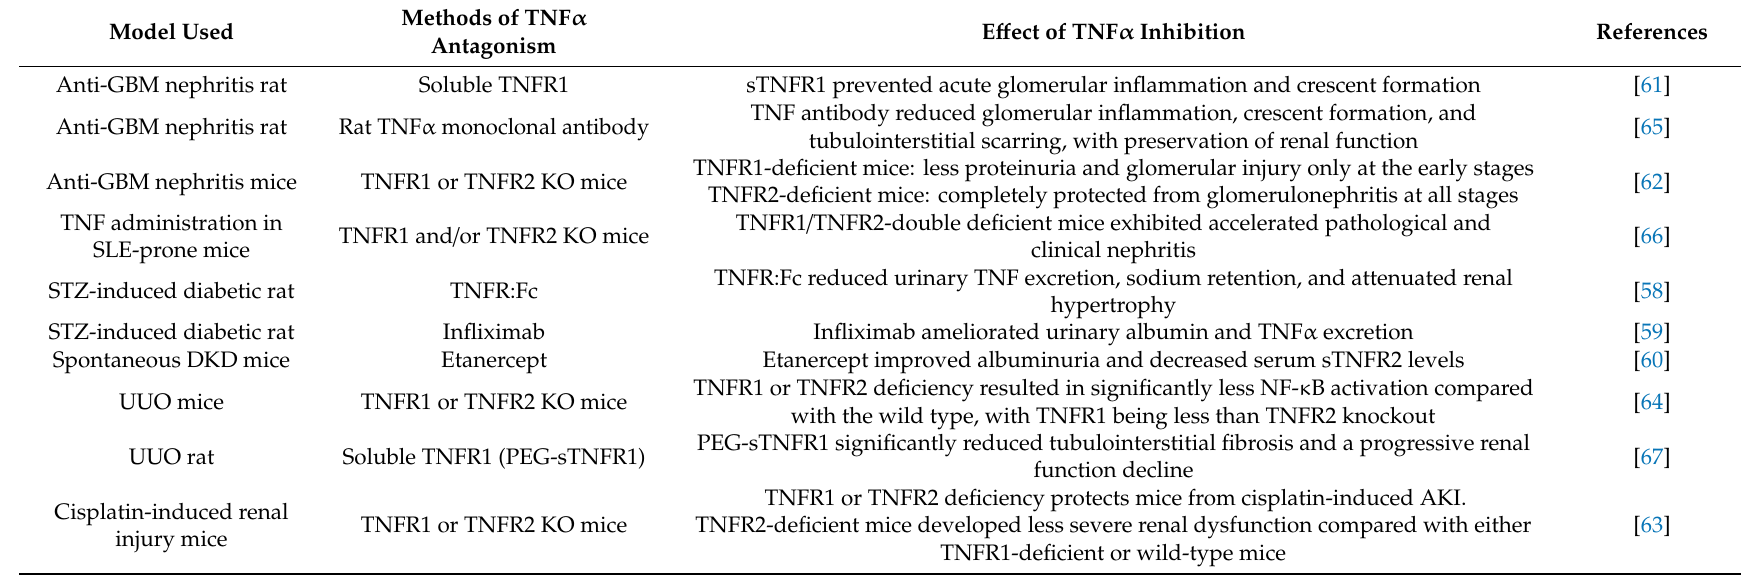
Table 4. Inhibitory e ff ects of tumor necrosis factor signal in animal